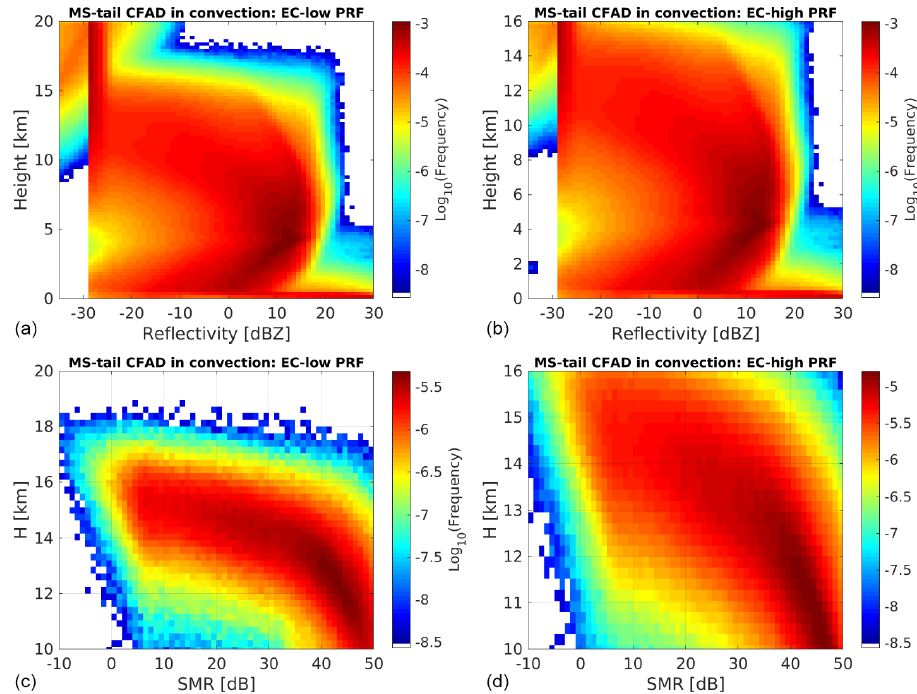
Figure 10. Same as Fig. 8 for the second-trip echoes generated by MS tails.